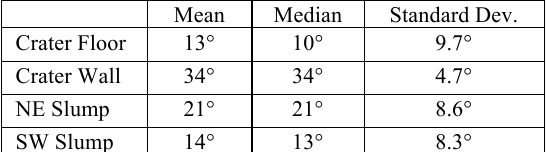
Table 1. Slope statistics for Giordano Bruno crater regions, calculated based on 5 m post spacing (15x15 m